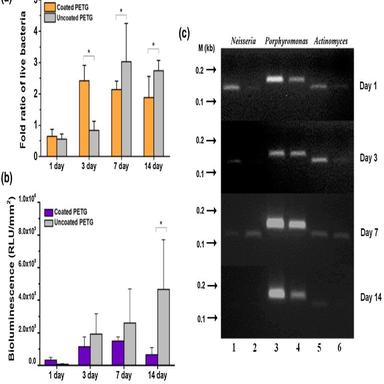
Viability of bacterial cells in dental plaque biofilms determined by (a) Live/Dead assay and (b) ATP-based luminescence. Data of Live/Dead assay expressed as fold changes with respect to value of uncoated specimen on day 1. Comparisons between groups at each time point were made using Mann–Whitney U test. The level of significance was set at p < 0.05. (c) Comparison of DNA derived from the members of Neisseria, Actinomyces and Porphyromonas using each genus specific primers. PCR amplifications were performe